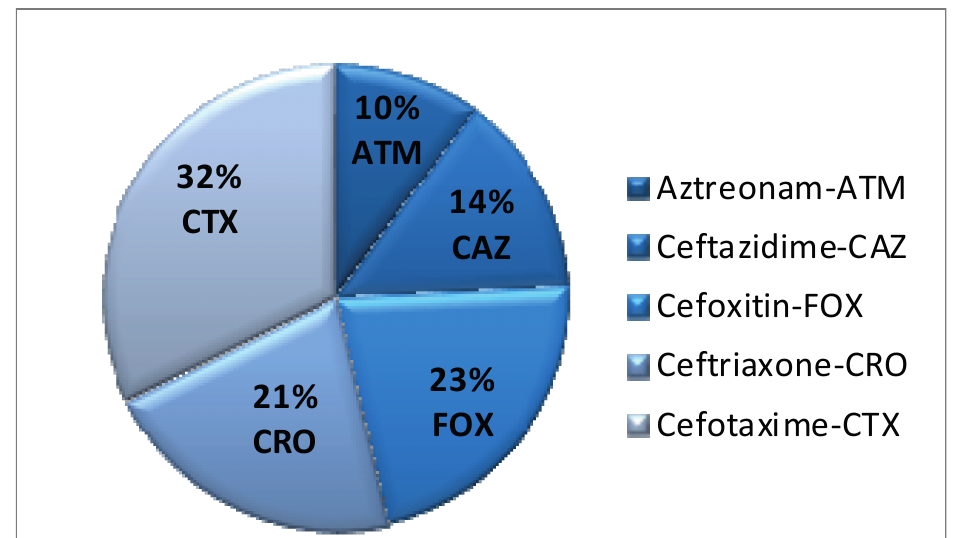
Figure 2. Percentage among the nineteen Salmonella serotypes isolates showing resistance to each of the tested β -lactam